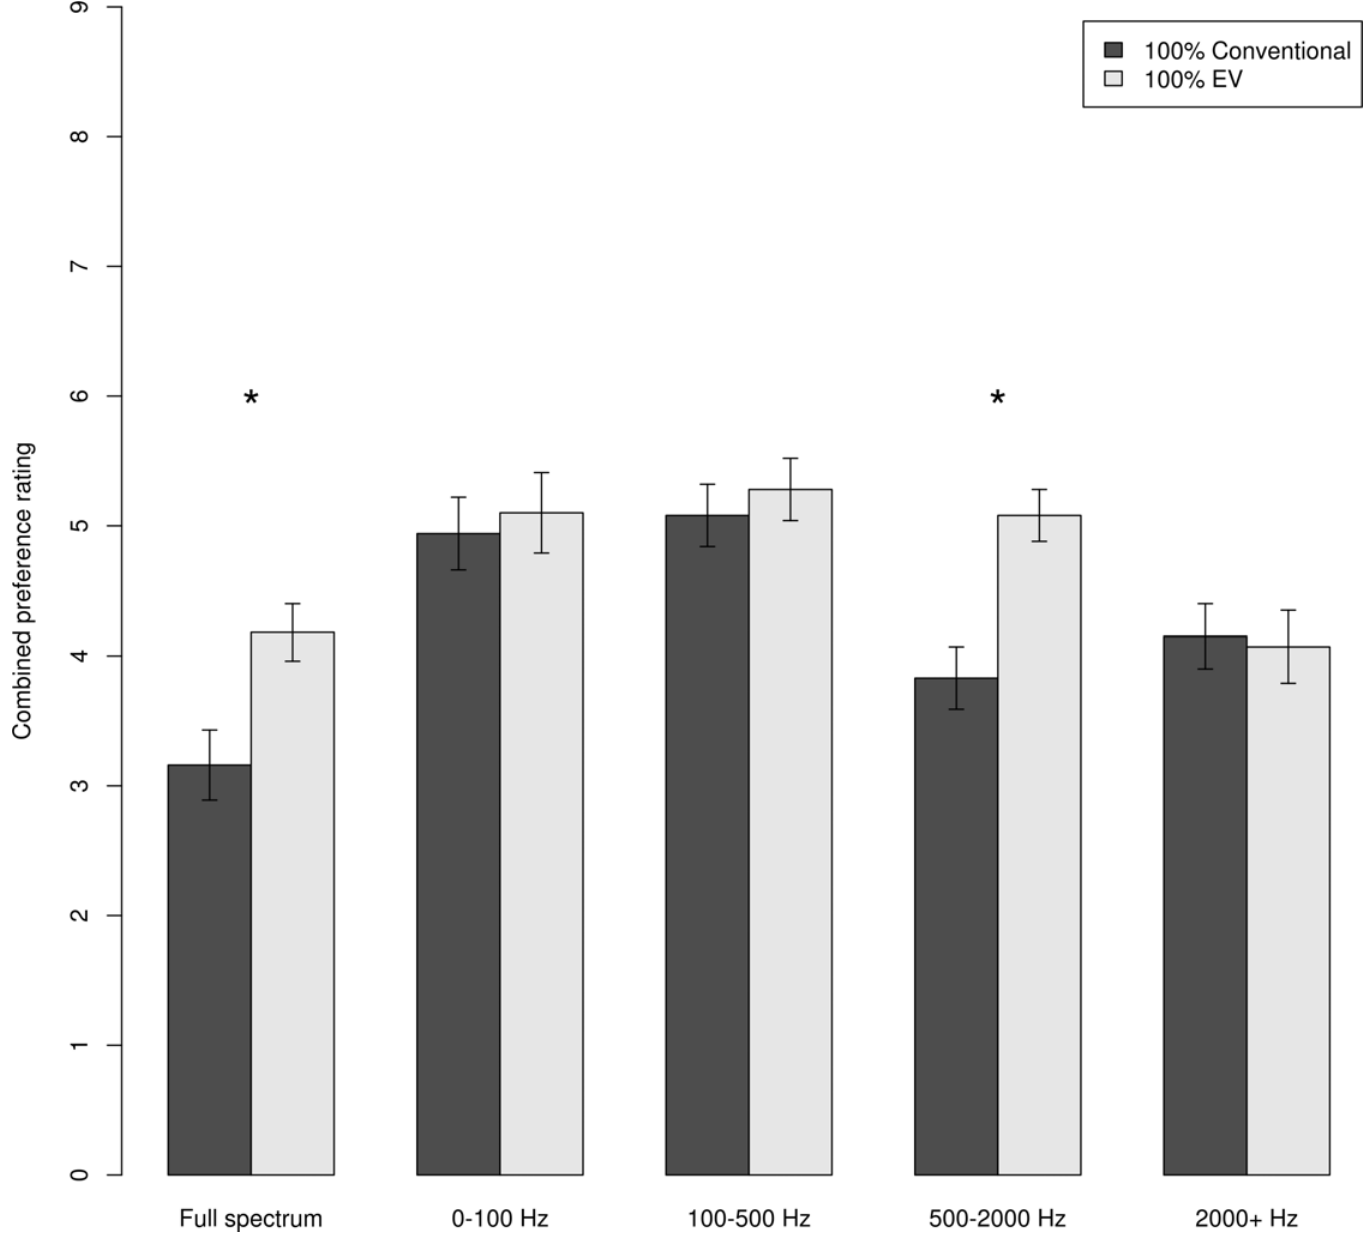
Fig 3. Mean preference ratings for simulated 100% conventional and 100% electric vehicle traffic noise. The five pairs show the five filtering conditions. Error bars represent standard errors of the